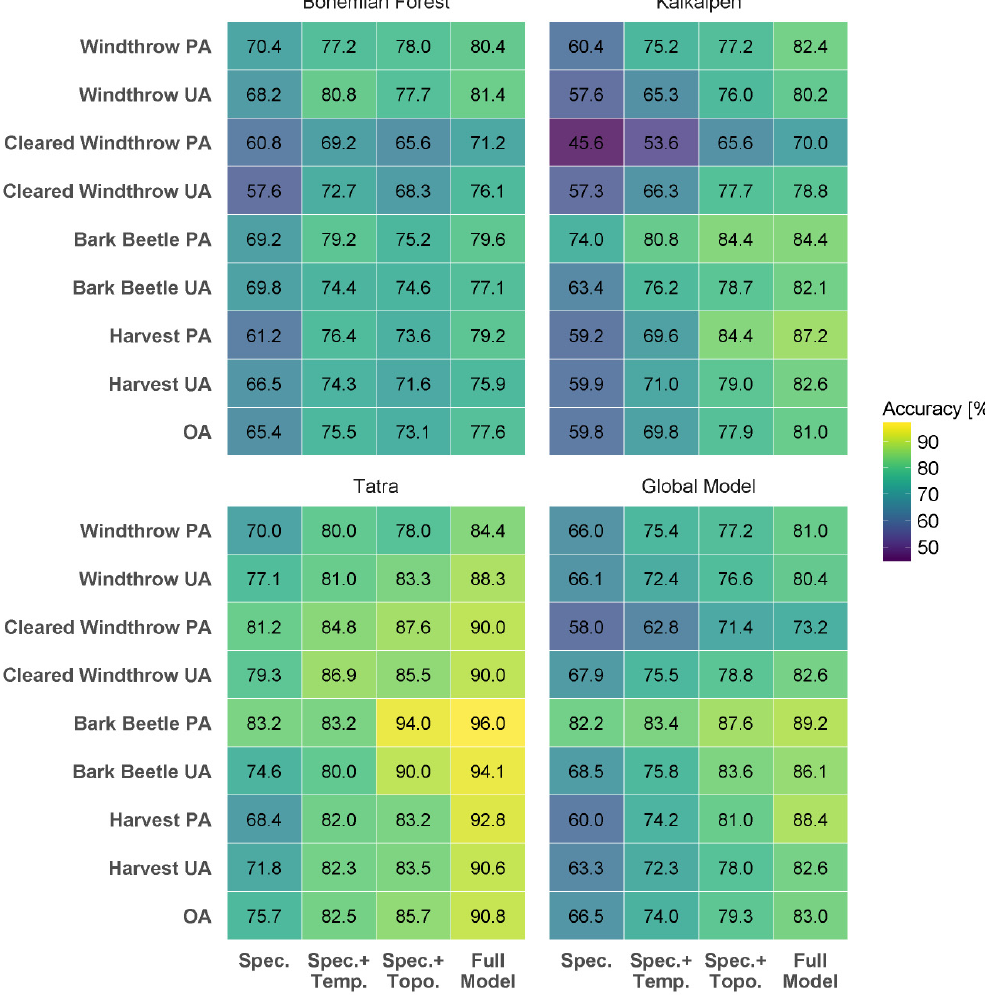
Figure 5. Heatmap of model accuracies including the different sets of metrics for the three site-specific models and the global model. PA = Producer’s accuracy, UA = User’s accuracy, OA = Overall accuracy. Spec. = Spectral, Temp. = Temporal, Topo. = Topography ‐ related.